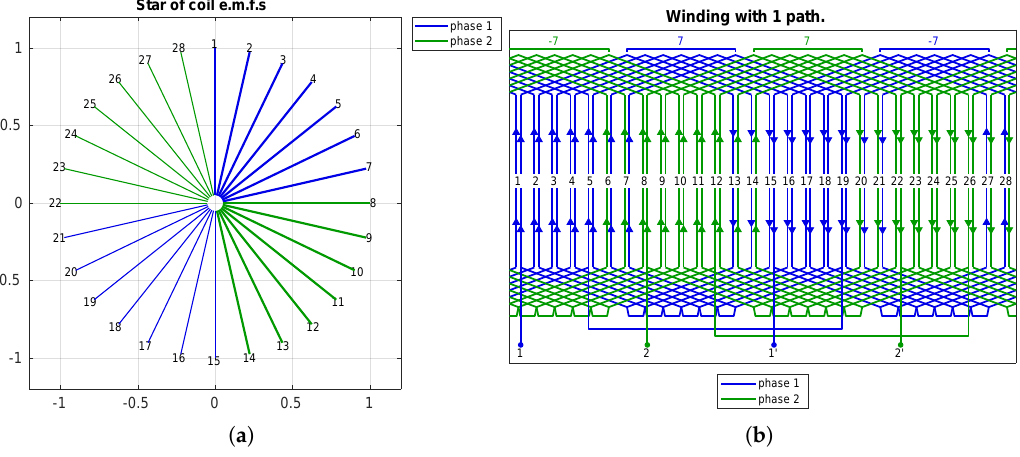
Figure 12. ( a ) Star of coils EMF and ( b ) Winding scheme for N = 28, m = 2, p = 1, q = 7 and y c = 12. Table 14. WDT for a single-layer, 2-phase winding with N = 28 and p = 1, after swapping.